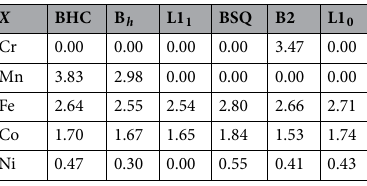
Table 2. The total magnetic moment of Cu X ( X = Cr , Mn, Fe, Co, and Ni) in the structure j . The figures are in units of µ B per a cell ( µ B the Bohr